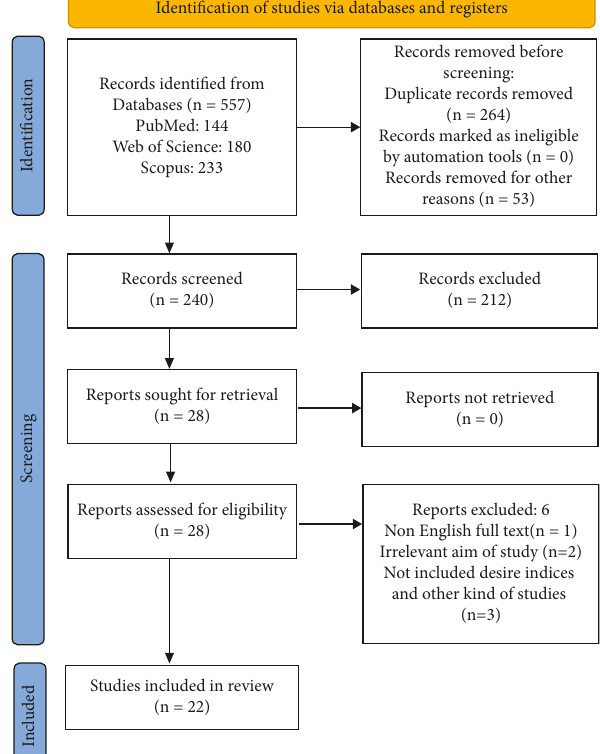
Figure 1: Flowchart for including studies in the